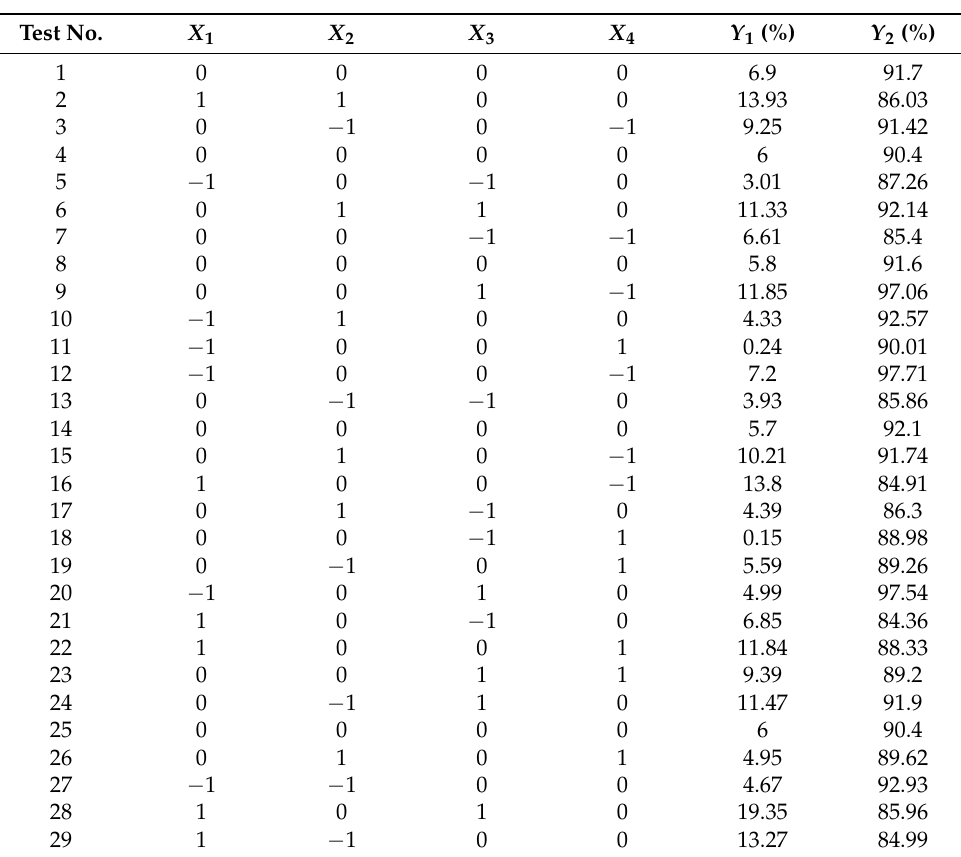
Table 3. Test scheme and results of the RSM experiments for MDR( Y 1 ) and SE( Y 2